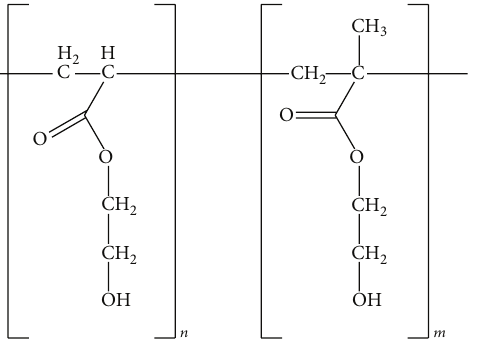
Figure 1: The effect of FA on the workability of mortar mixes without latexes.